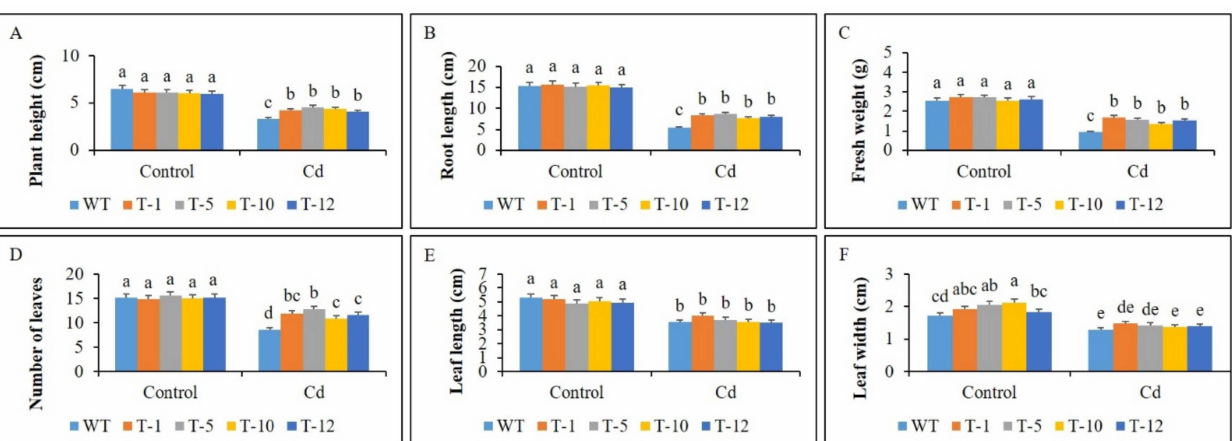
Figure 2. Transcript levels of ethylene biosynthesis ( A , B ) and signaling ( C , D ) genes in the three different stages of WT and transgenic petunia cv. ‘Mirage Rose’ flowers. Data represent the means of three replicates, and error bars indicate standard error. Means with the same letters are not significantly different by least significant difference test (LSDT, p < 0.05).